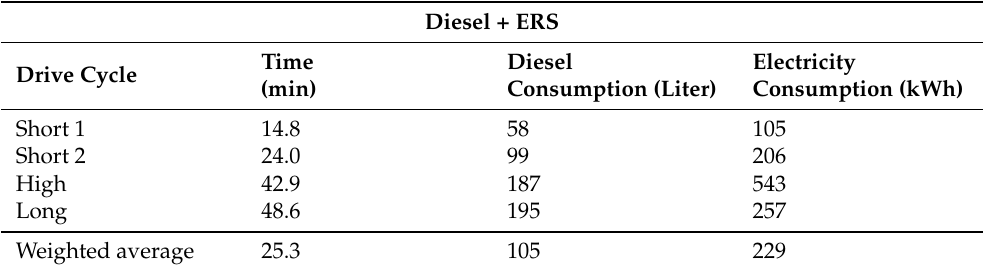
Table 4. Cycle time, fuel consumption and electricity consumption for the drive cycles under diesel operation with ERS.